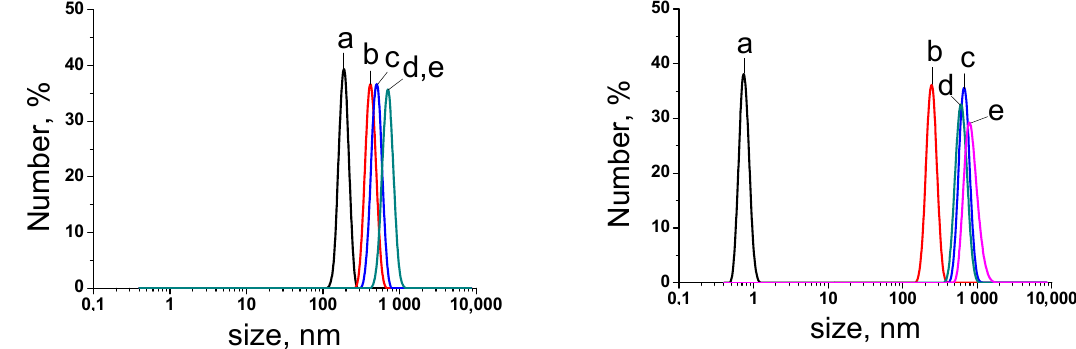
Figure 3. Gypsum mean particle size change within the induction time for A ( left ) and B ( right ) supersaturated solutions (0.05 mol ∙ L ‒ 1 ): 3 min (a); 4 min (b); 6 min (c); 10 min (d) and 15 min (e) after the stock brines get mixed.